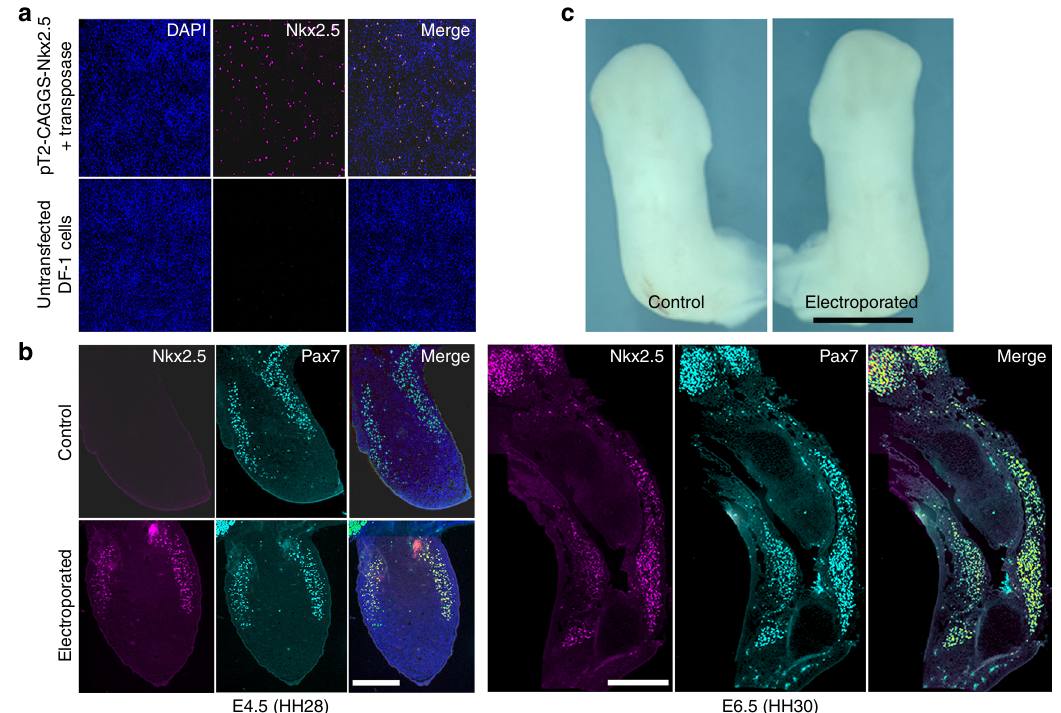
Fig. 5 Mis-expression of Nkx2.5 in somites and developing muscle. a Demonstration of Nkx2.5 expression in chicken DF1 fi broblasts using pT2-CAGGS- Nkx2.5 detected by anti-Nkx2.5 immunostaining. b Co-expression of Nkx2.5 and Pax7 in somite-derived muscle precursors in chick limb buds and limbs. c Electroporated limb demonstrating normal phenotype ( n = 4). Scale bar = 250 μ m ( b ), 1 mm ( c